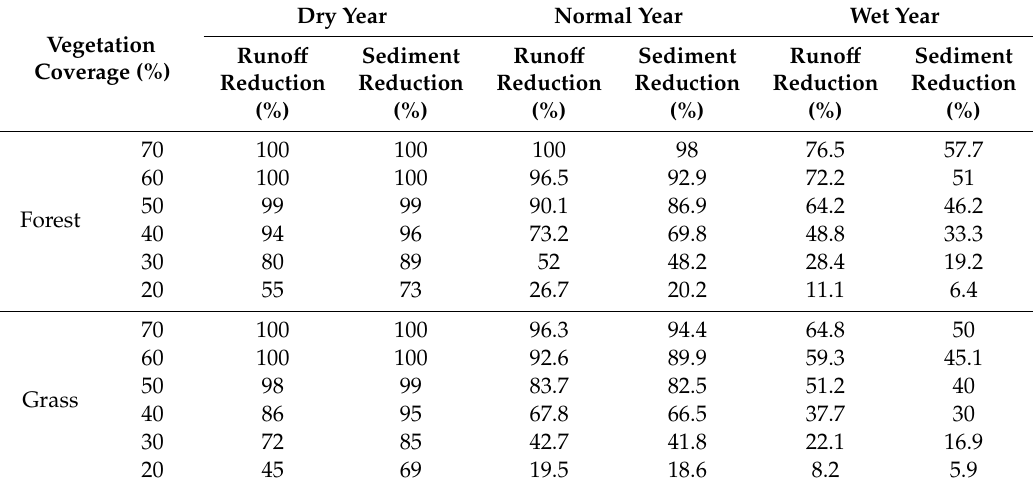
Table 3. The reduction percentage in runo ff and sediment generation of forestland and grassland of di ff erent quality.